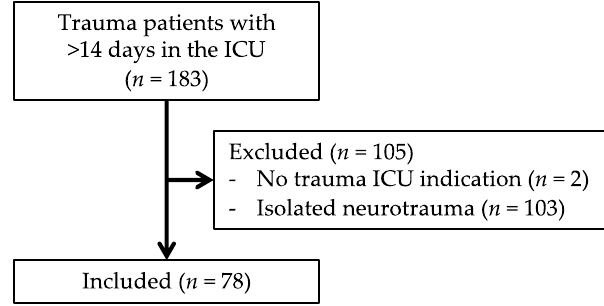
Figure 2. Flowchart of patient